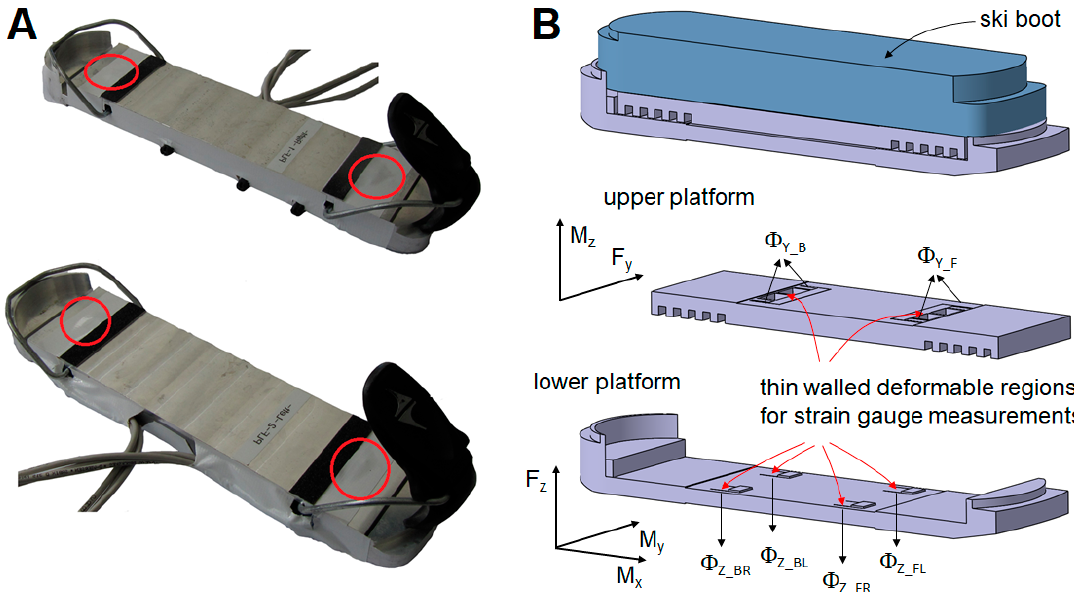
Figure 2. ( A ) The two manufactured forces platforms with sensors position marked in red. ( B ) Schematic view of the sensor, composed of two stages. The upper part allows the Fy and Mz components to be measured, while the lower part aims to measure Fz , Mx , and My . Φ indicates the different recorded signals.